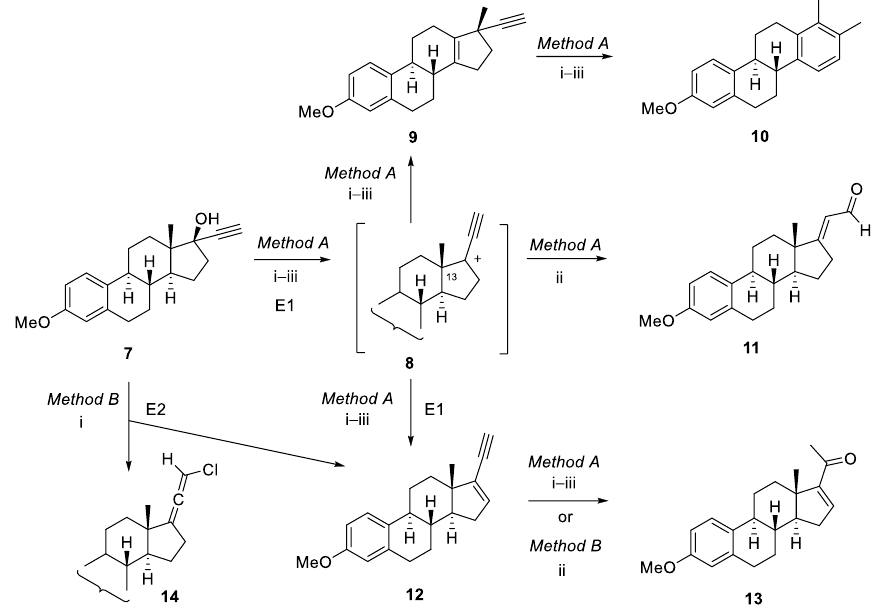
Scheme 2. Synthesis of enone 13 from mestranol ( 7 ): competitive routes under Brønsted